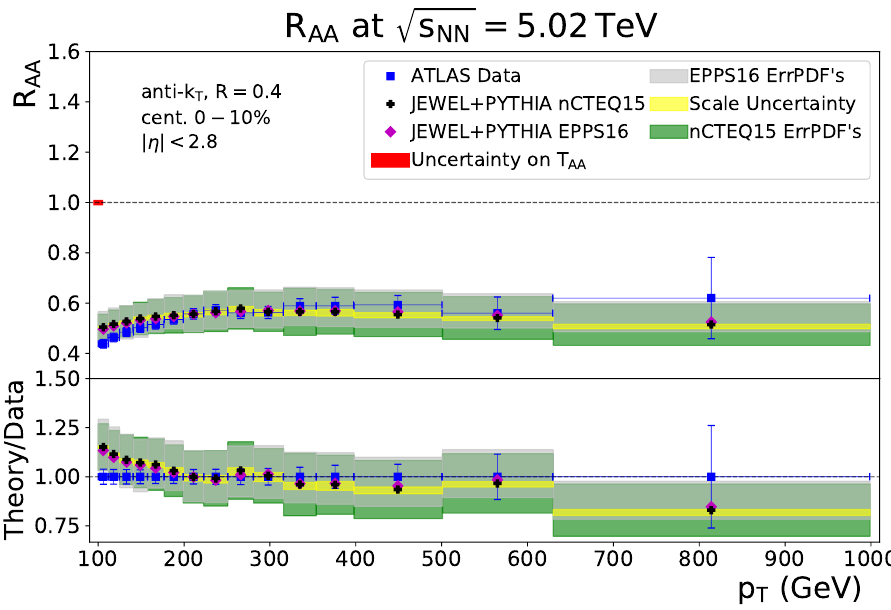
√ Figure 8 . Nuclear modification factor R AA for jets with radius R = 0 . 4 at s NN = 5 . 02 TeV measured by ATLAS in the rapidity range | η | < 2 . 8 and the centrality range 0 – 10% [8] and calculated with JEWEL. Scale (nuclear PDF) uncertainties are shown as yellow (green and grey) shaded bands. The overall normalisation uncertainty on T is indicated by the box around AA